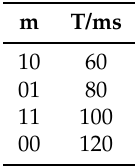
Table 1. L-Bits to N-Packets